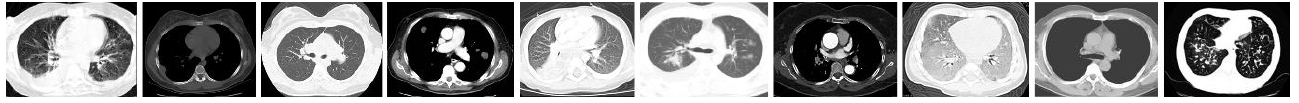
Figure 5. Significant variation among CT images caused by different